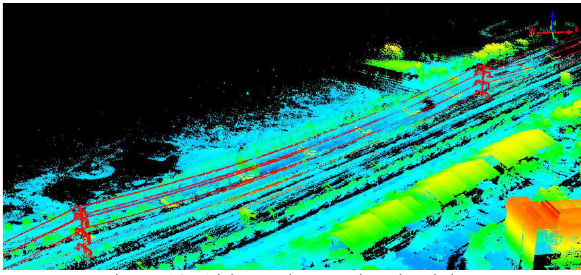
Table 2. AS-100 Airborne Laser System Parameter Table